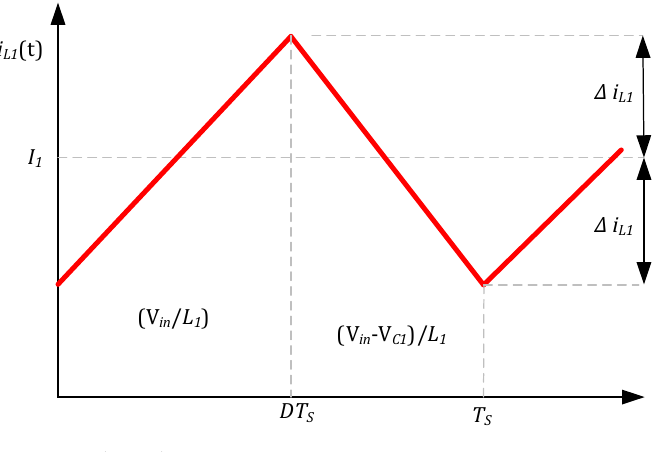
Figure 7. The inductor L 1 current.